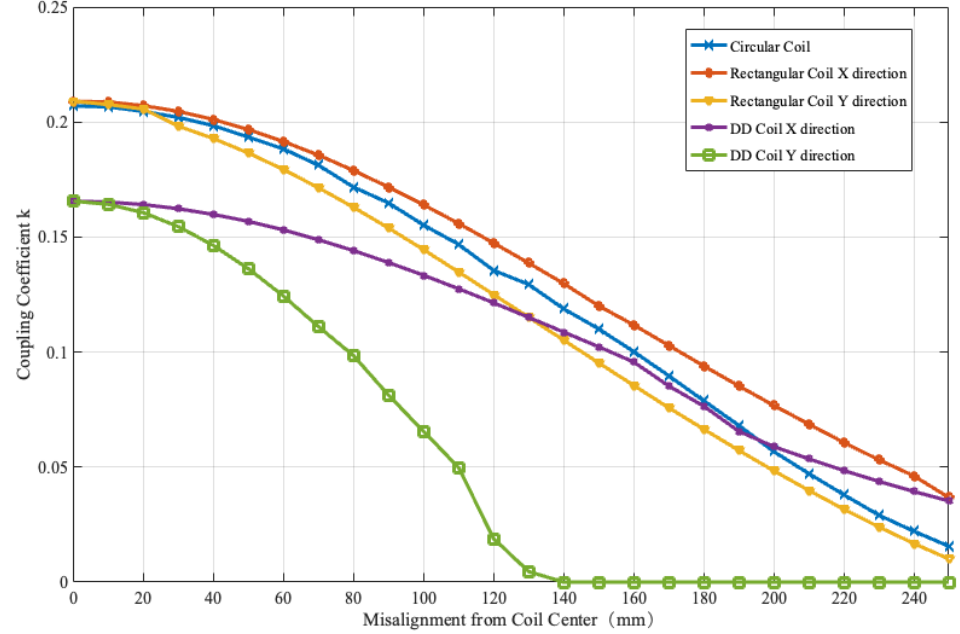
Figure 7. Magnetic coupling variation of coils under different